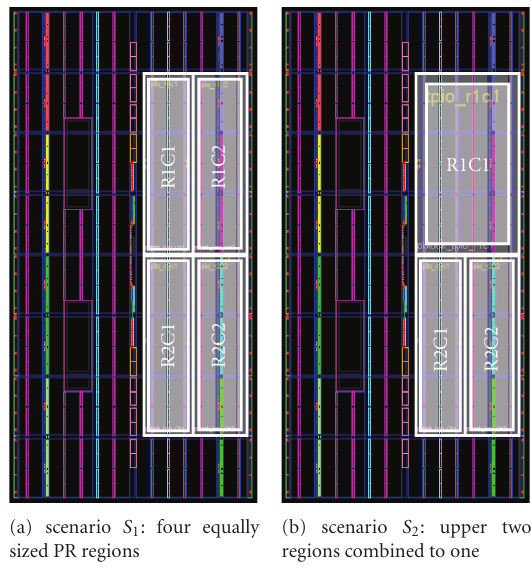
Figure 6: Static design intersecting PR